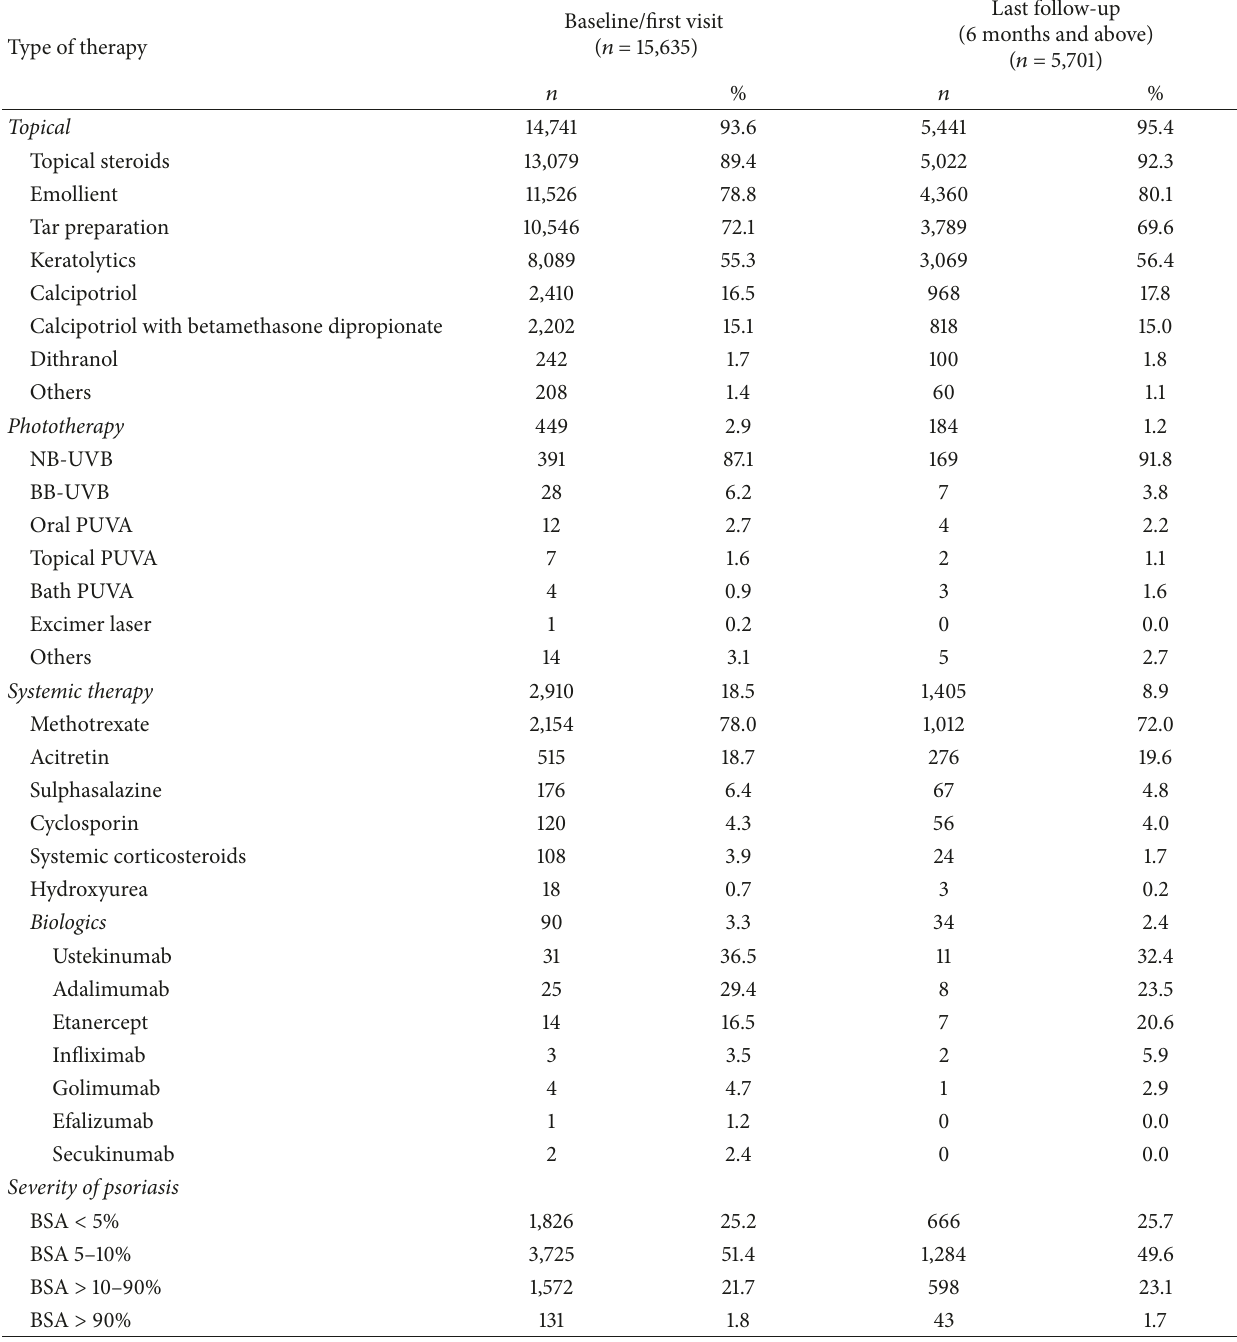
Table 2: Types of treatment and